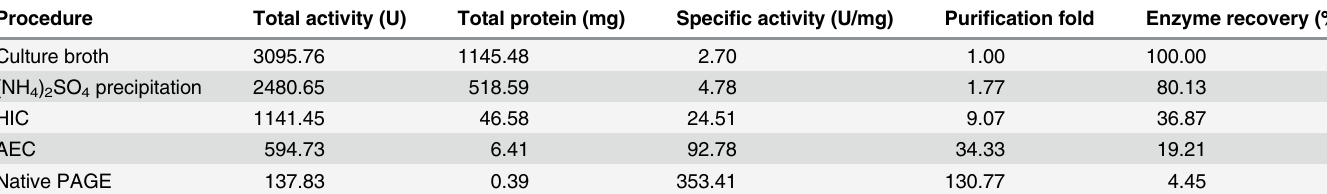
Table 1. Summary of the purification procedure of an amylolytic enzyme from Talaromyces pinophilus 1 – 95. Procedure